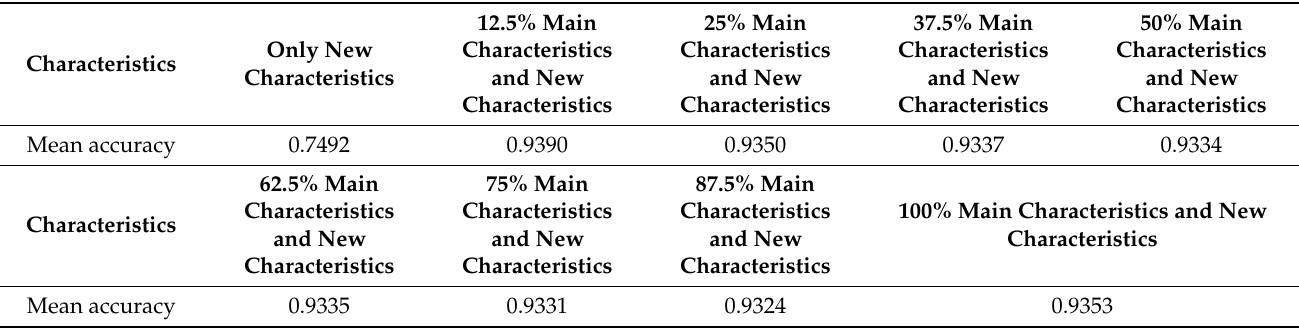
Table 6. Assessment of characteristics chosen.